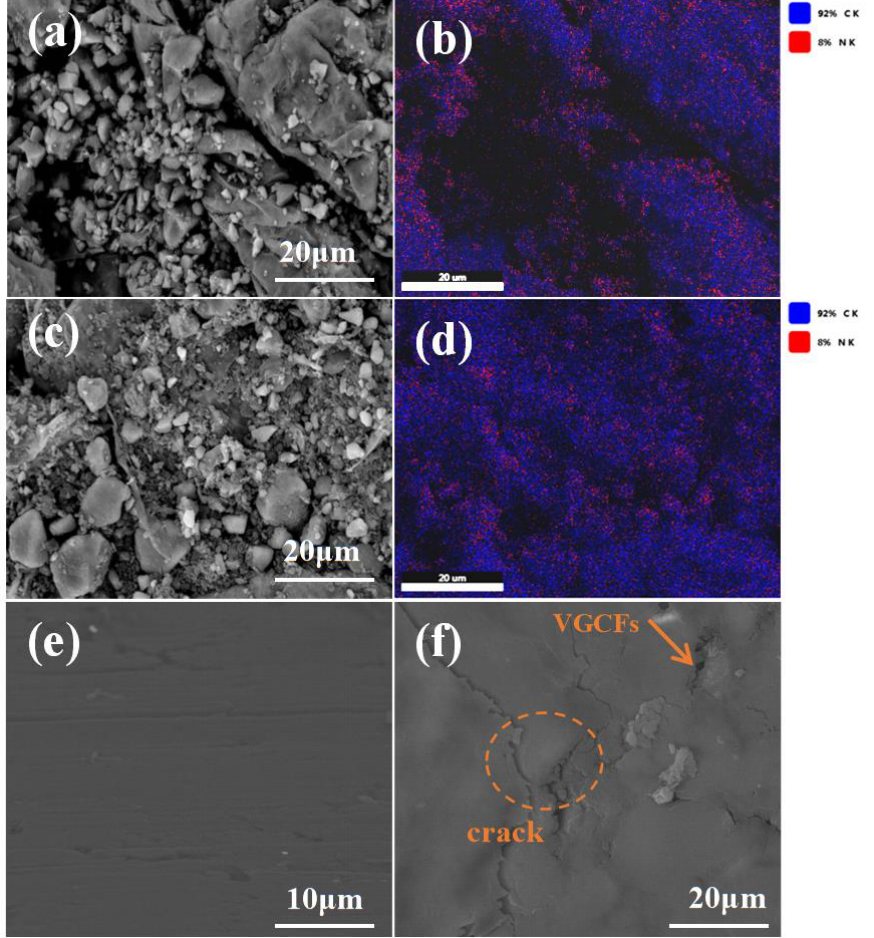
Figure 9. ( a , b ) 40% PI BPs EDX mapping; ( c , d ) 40%PI/2% VGCFs BPs EDX mapping; ( e ) Bipolar plate surface morphology (no VGCFs added); ( f ) Bipolar plate surface morphology (with 2.5% content of VGCFs added).